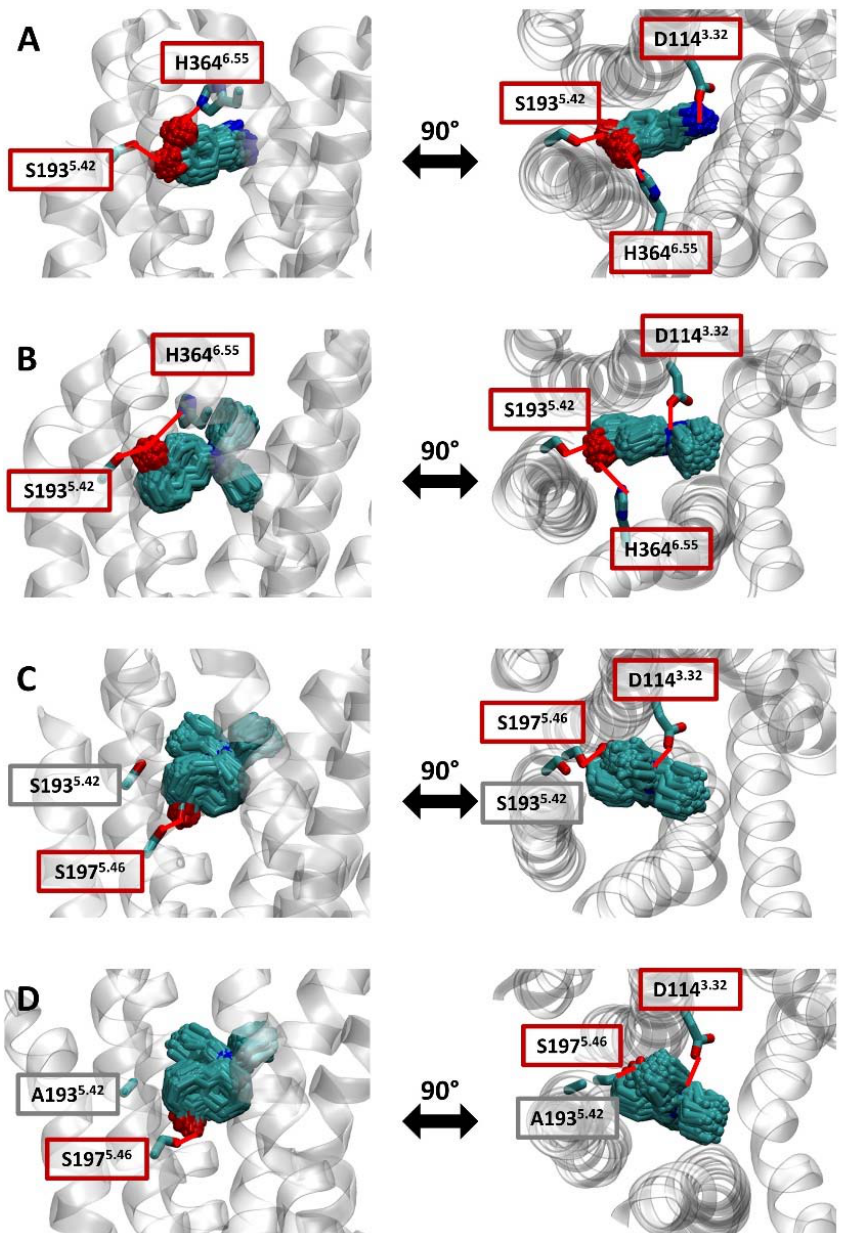
Figure 4. Binding modes of studied compounds within the WT D 2 R and the S193 5.42 A mutant receptor. Simulations of ( A ) DA, ( B ) (S)-5-OH-DPAT, and ( C ) (R)-5-OH-DPAT in complex with the WT D 2 R and ( D ) (R)-5-OH-DPAT in complex with the S193 5.42 A D 2 R were clustered based on the root-mean-square deviation (RMSD) of the ligand. For each of the systems, the poses of the ligand within the most populated cluster are depicted in licorice. For each of the binding modes, the studied position 193 5.42 , as well as the residues that formed polar interactions with the ligand, are also shown in licorice. Polar interactions are highlighted by red lines.